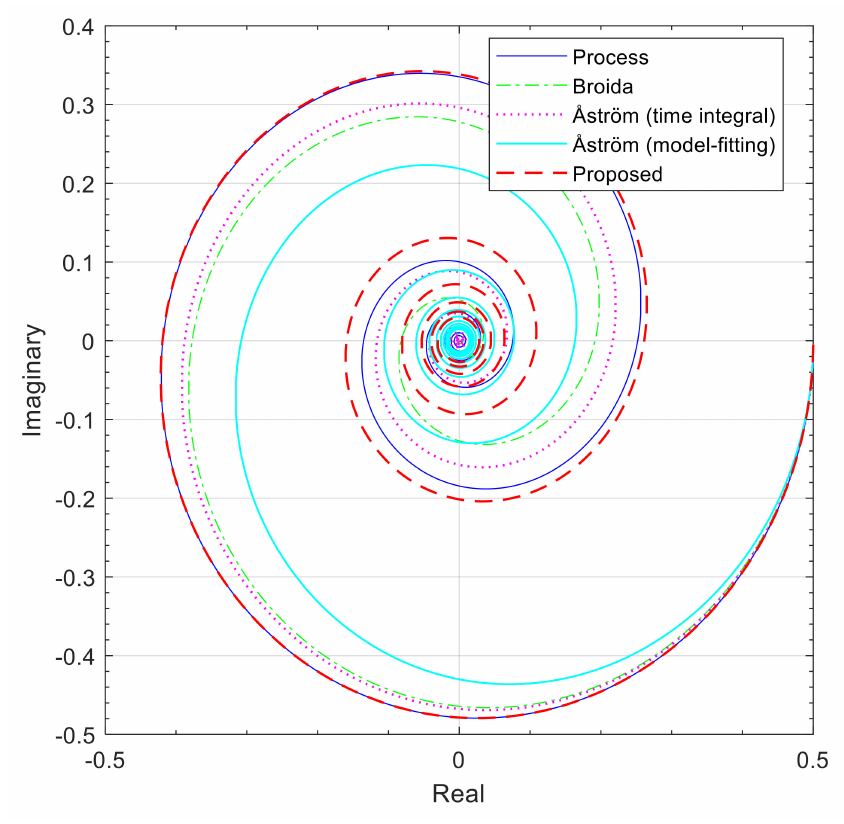
Figure 14. The Nyquist plots for process G P3